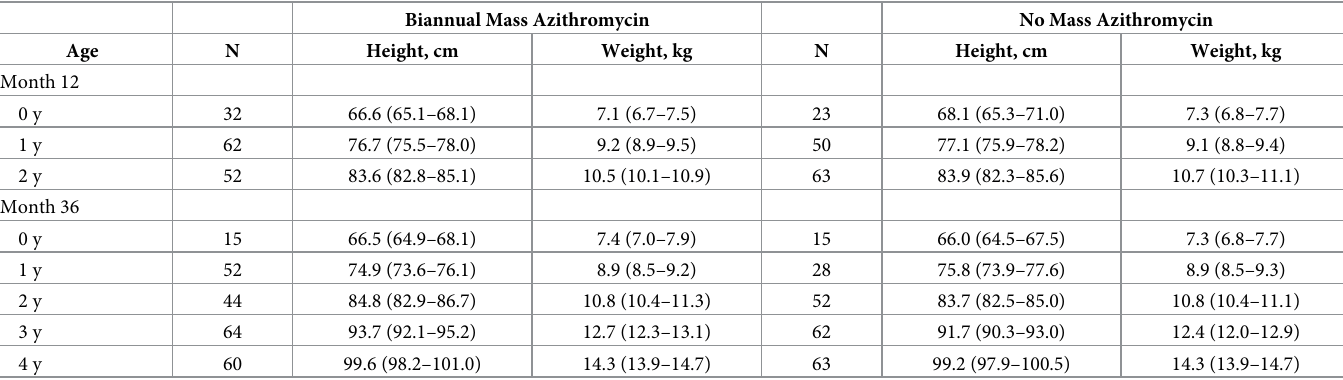
Table 4. Anthropometric assessment stratified by follow-up visit and